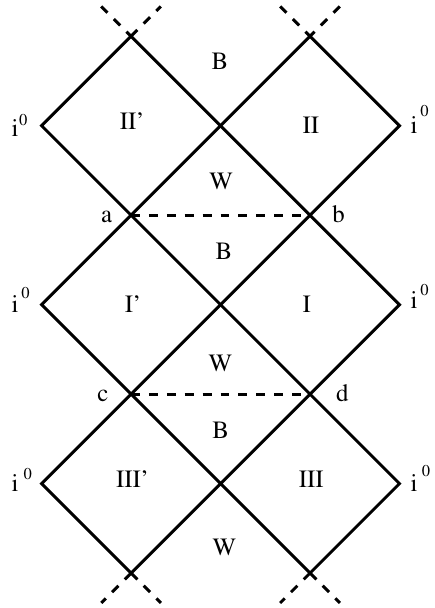
Figure 1. The Penrose diagram for the AOS LQBH. The dashed horizontal lines ab and cd represent the transition surfaces (throats), and the regions marked with B is the BH interior, and the regions marked with W is the WH interior, but there are no spacetime singularities, so the extensions are infinite along the vertical line in both directions. Regions marked with I, I’, II, II’, III, and III’ are asymptotically flat regions but with a falling rate slower than that of the Schwarzschild black hole